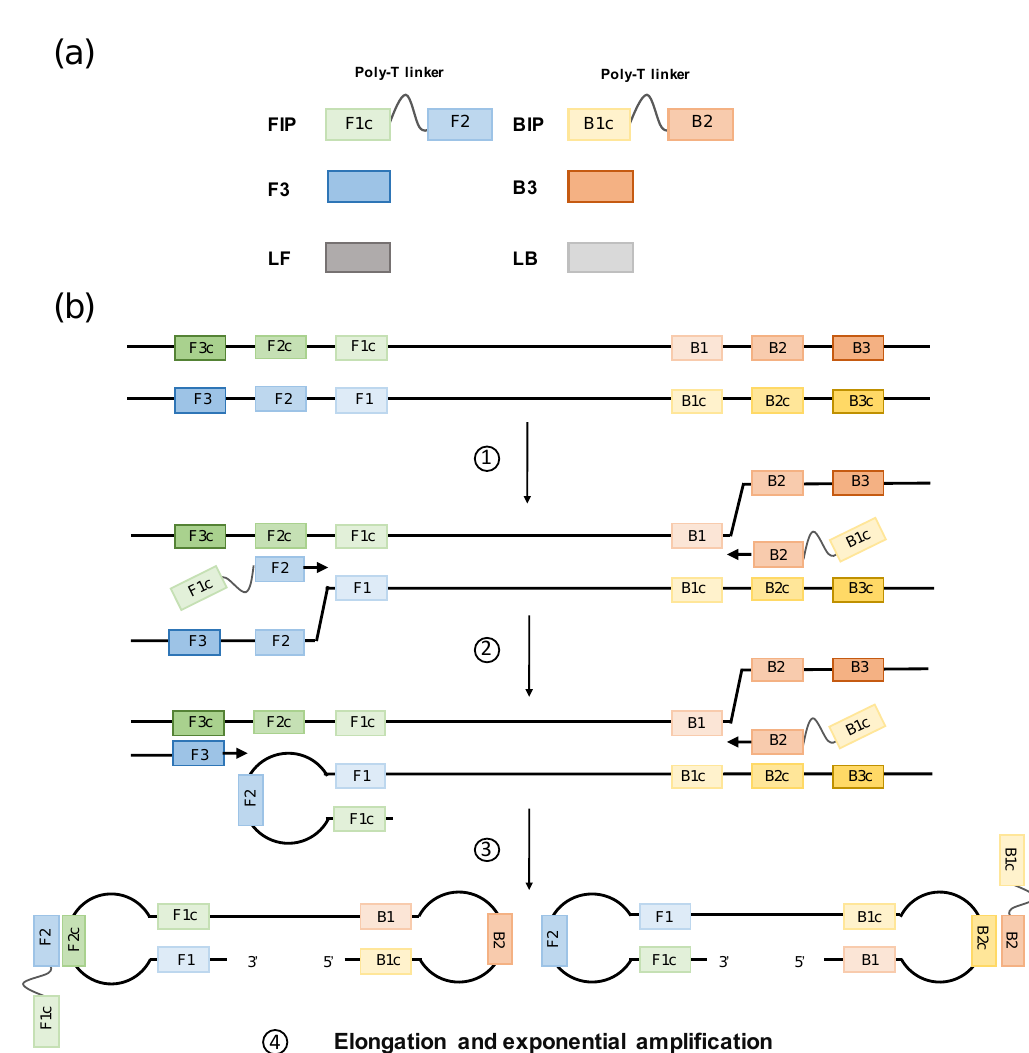
Figure 2. Loop-mediated isothermal amplification (LAMP): primer design and mechanism. ( a ) A typical set of LAMP primers is represented. LAMP reaction requires four primers, two inner primers (forward inner primer (FIP) and backward inner primer (BIP)) and two outer primers (F3 and B3). FIP and BIP each contains two sequences (usually linked by a poly-T linker) corresponding to the sense and antisense sequences of the target DNA. Additional loop primers (loop-forward (LF) and loop-backward (LB)), can be included, shortening the reaction time up to 30 minutes. ( b ) LAMP amplification process can be divided into two phases. At the first phase: 1. FIP hybridizes to the target DNA and Bst polymerase starts complementary strand synthesis. 2. The outer primer F3 starts strand displacement of the elongate FIP primer, releasing single stranded DNA (ssDNA). That ssDNA is used as template for the backward primers. The inner primer BIP hybridizes and starts strand synthesis at the ssDNA and then is displaced by the B3 primer. 3. Now, as the 3 (cid:48) and 5 (cid:48) ends are complementary to sequences further inwards, stem-loops DNA structures are formed and subsequently used as targets to start an exponential amplification second phase. 4. In the second phase, self-priming and the elongation of 3 (cid:48) end induces displacement of the 5 (cid:48) end and subsequently, the hairpin comes off and the newly synthesized strand folded. Further self-priming repetitions generate many amplicons with cauliflower-like structures. In addition, FIP and BIP primers now hybridize to the loop structures formed and initialize strand synthesis and subsequent